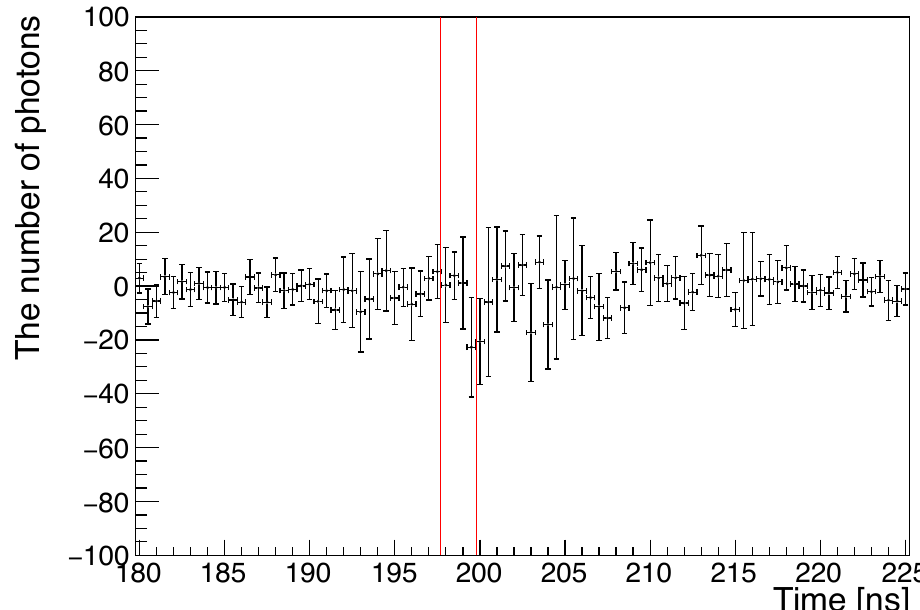
Figure 9. Arrival time distribution of reconstructed photons after subtraction between the four patterns based on Equation (5) over the entire time range in Figure 8. The interval between the two red lines indicates the expected time windows for FWM photons via ALP-exchange to